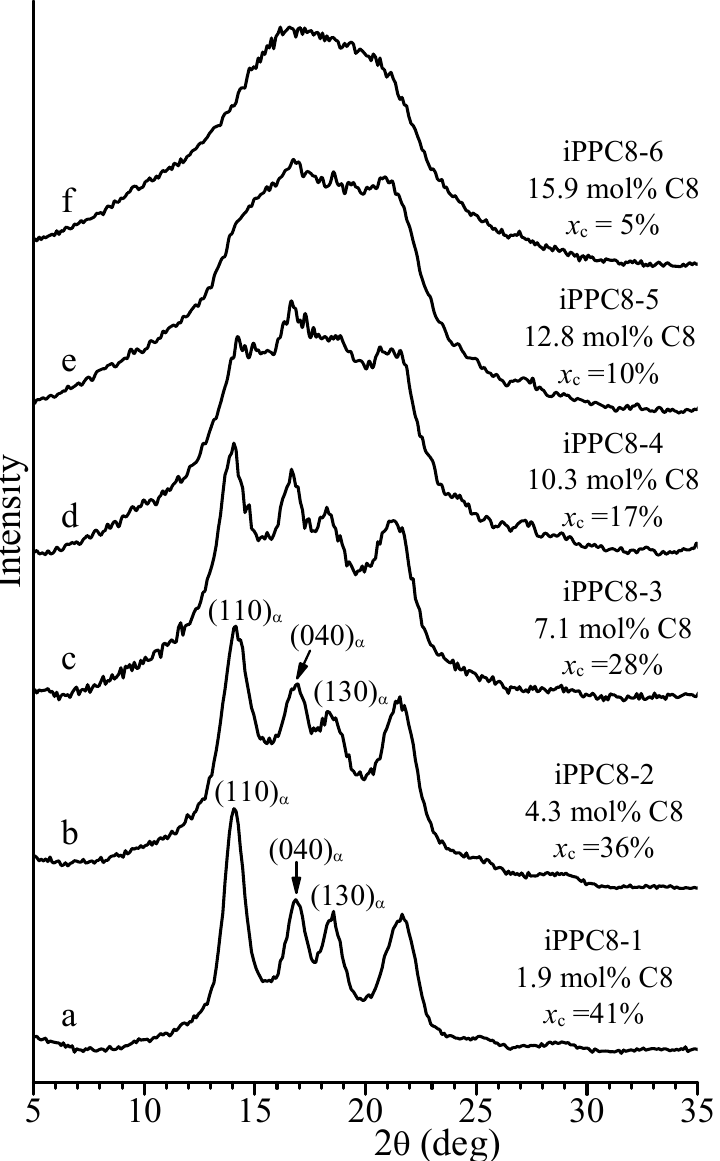
Figure 1. X-ray diffraction profiles of as-prepared samples of iPPC8 copolymers of the indicated octene concentration ( a – f ). The (110) α , (040) α , and (130) α reflections at 2 θ = 14 ◦ , 17 ◦ , and 18.6 ◦ , respectively, of the α form of iPP and the values of the degree of crystallinity x c are indicated. These data indicate that the γ form of iPP does not crystallize in these iPPC8 copoly- mers, even at high octene concentrations. Instead, this occurs in copolymers of iPP with ethylene (iPPC2) [72], butene (iPPC4) [72,81,92], pentene (iPPC5) [82,90,91,93], and hex- ene (iPPC6) [68,69,74,77]. Moreover, Figure 1 also indicates that the trigonal δ form